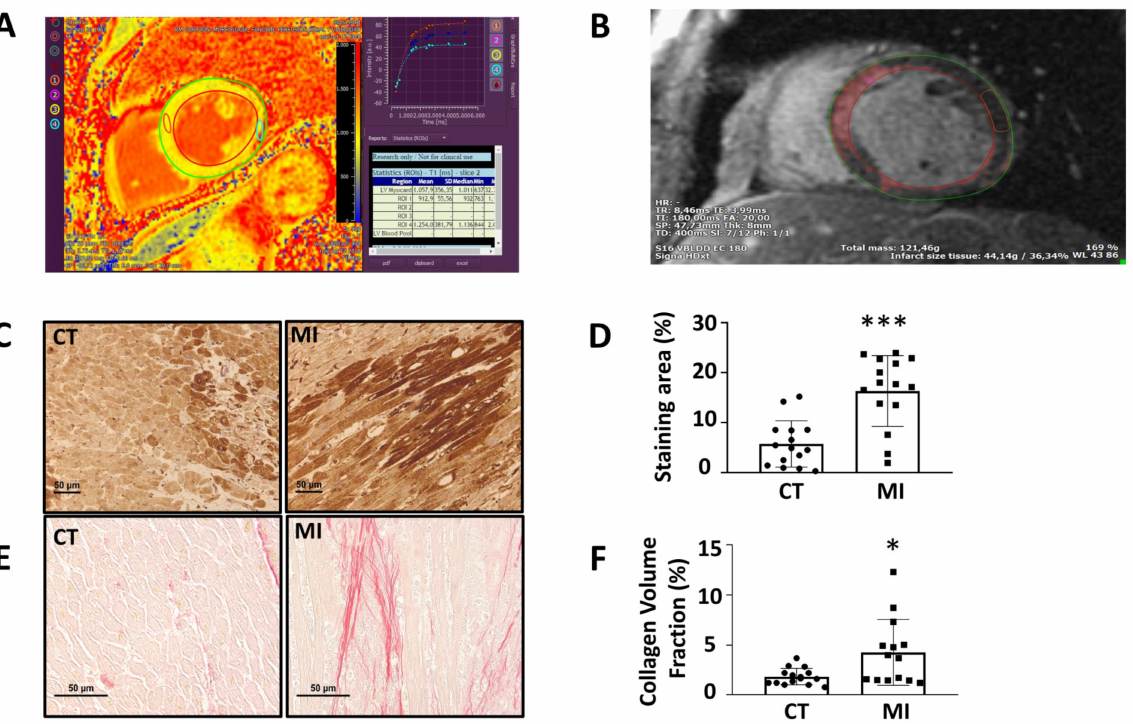
Figure 5. ( A ) A representative image of T1 map with MOLLI sequences of a patient with acute myocardial infarction; ( B ) a representative image of LGE quantification. The mean signal intensity was determined by drawing a region of interest (ROI) in a portion of the normal myocardium, and for comparison, a threshold technique was performed using 5 SDs above the mean signal intensity for the normal nulled myocardium. ( C ) Representative microphotographs of cardiac sections of BiP staining from patients with (MI) or without myocardial infarction (CT); (magnification 20 × ); ( D ) quantification of BiP staining in cardiac sections from patients with or without myocardial infarction; ( E ) representative microphotographs of cardiac sections staining with picrosirius red of patients with or without myocardial infarction (magnification 40 × ). ( F ) Quantification of collagen volume fraction (CVF) in cardiac sections of patients with or without myocardial infarction. * p < 0.05, *** p < 0.001 vs. CT